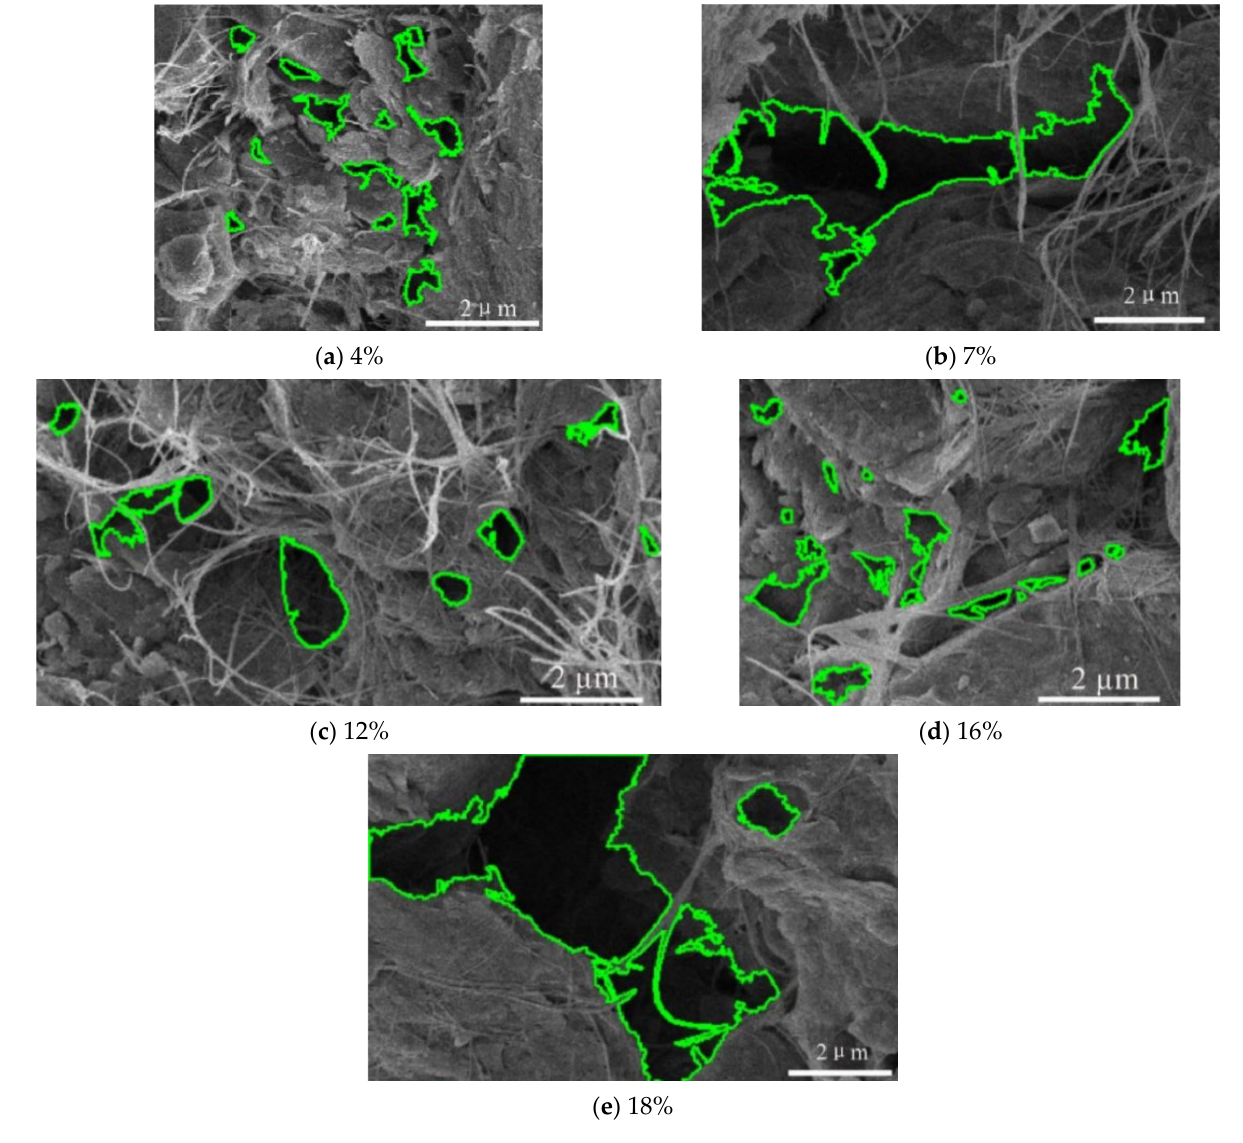
Figure 4. Microstructure characteristics of N-1 under different absorption conditions.